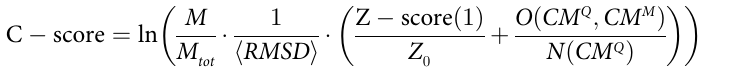
S1 Table. Summary of the threading alignments produced by CEthreader for the 614 test proteins in Benchmark